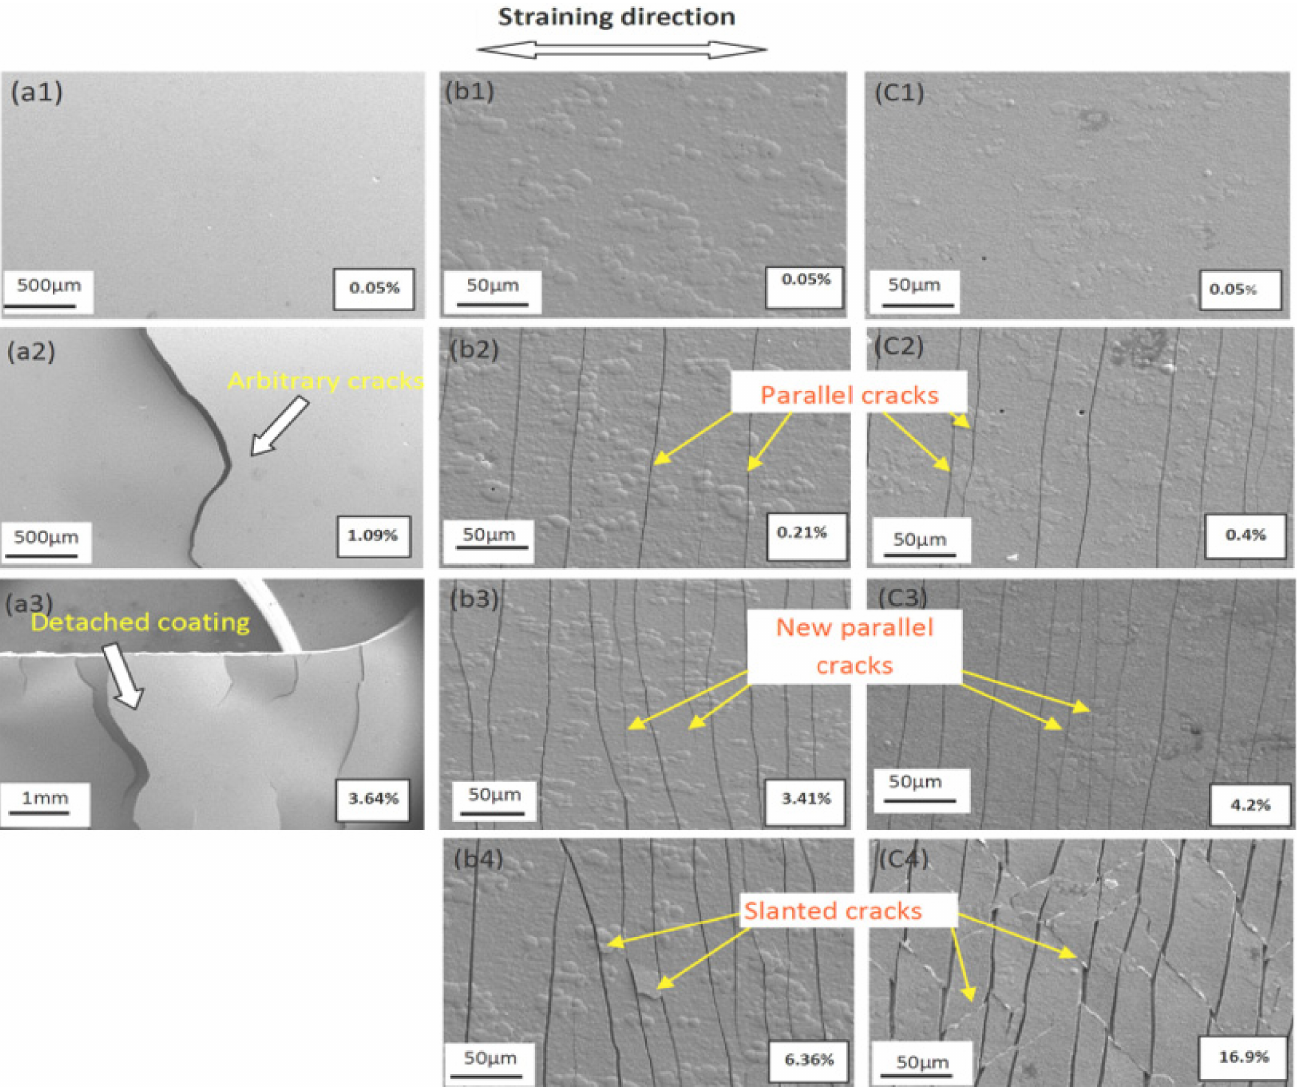
Figure 5. Cracking patterns detected by SEM in electroless Ni-P coatings by straining: ( a ) the spallation of the as-deposited coatings at a small strain level and ( b , c ) parallel and slanted cracks formed for the heat-treated samples at 400 and 600 ◦ C, respectively